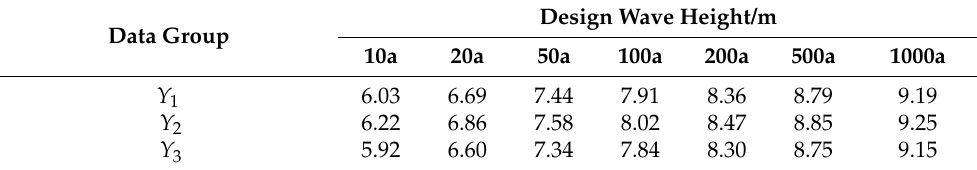
Table 9. Design wave